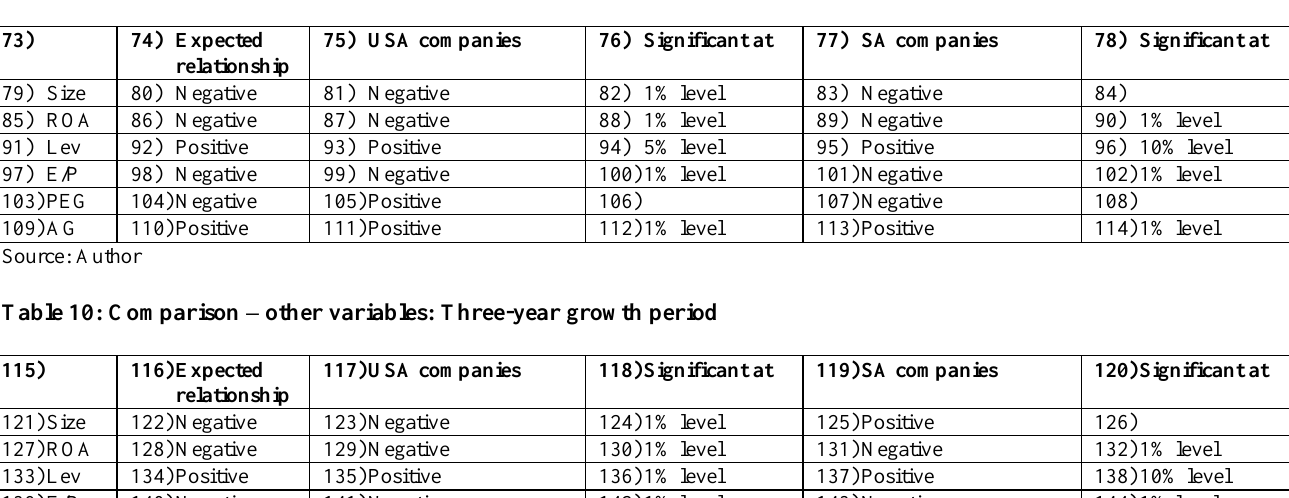
Table 9: Comparison – other variables: One-year growth period